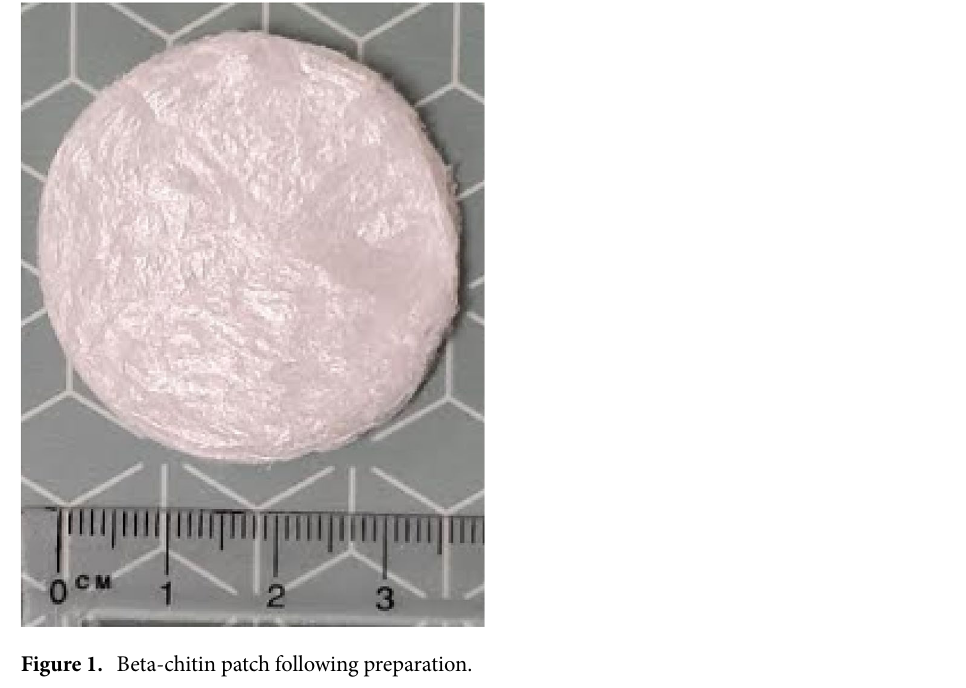
Figure 1. Beta-chitin patch following